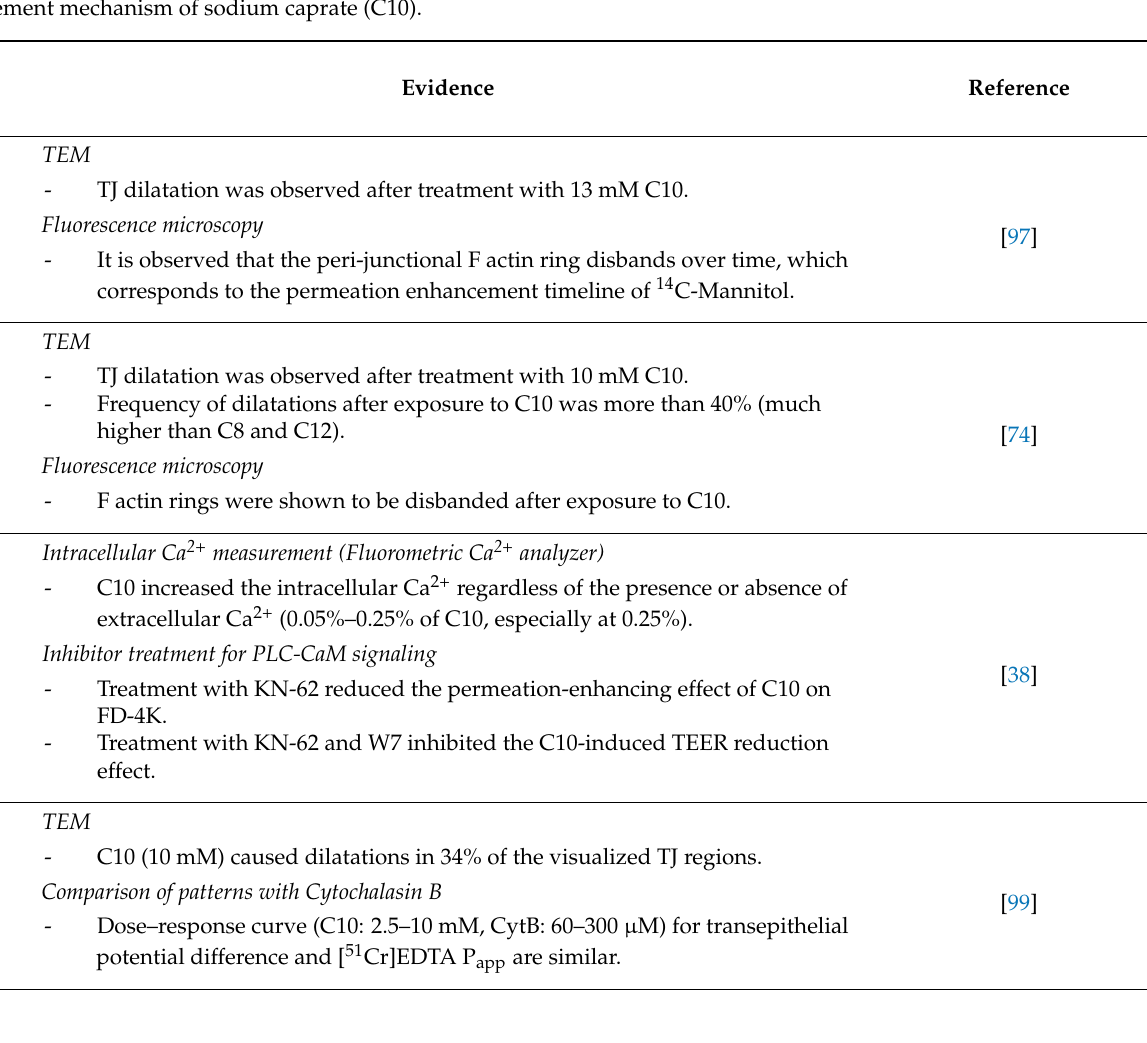
Table 3. Studies on the permeation enhancement mechanism of sodium caprate